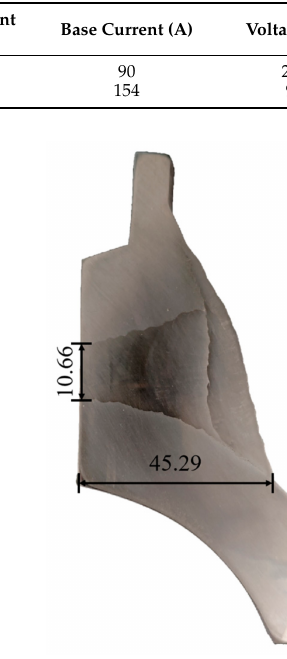
Table 2. Summary of the welding parameters.